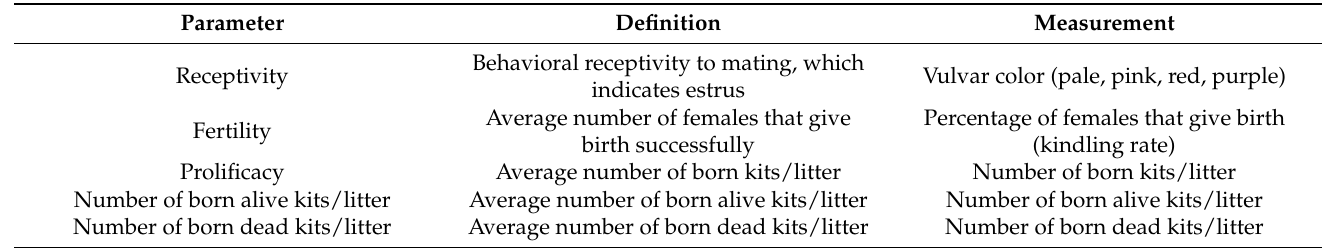
Table 1. Reproductive parameters analyzed with their corresponding definition and way of measuring.